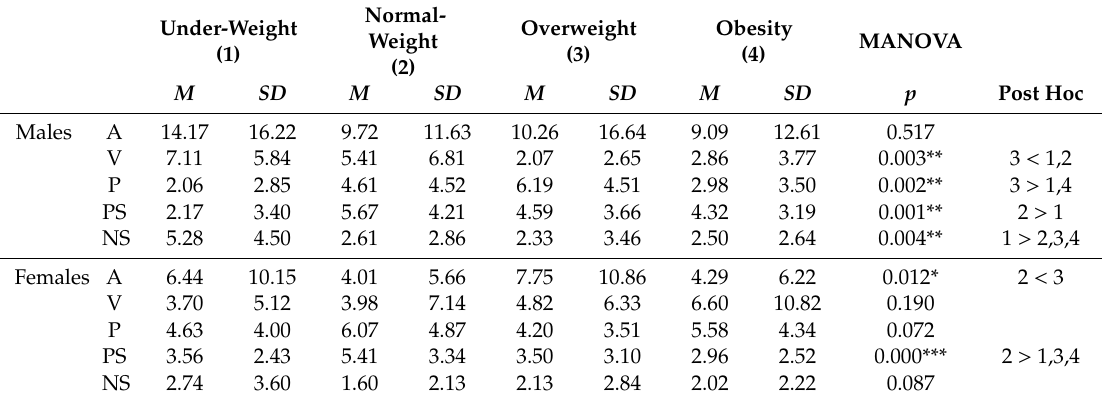
Table 4. Average scores in the nominations according to the weight status. MANOVA and post-hoc.